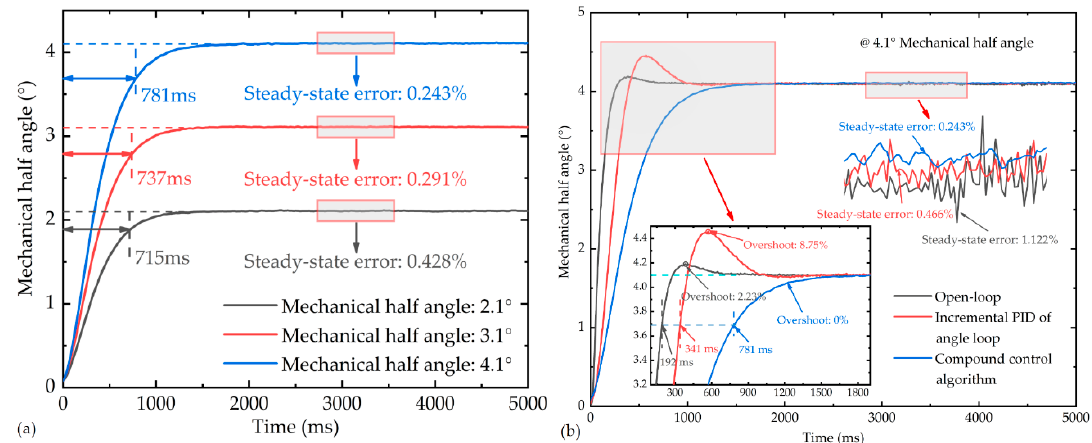
Figure 12. ( a ) Step response of the compound control system at different set mechanical half angles; ( b ) comparison of step responses in different situations. The target mechanical half angle is set to 4.1°.